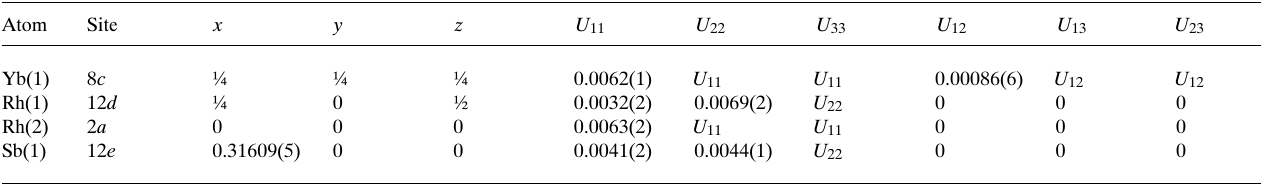
Table 2. Atomic coordinates and displacement parameters (in Å 2 ) .